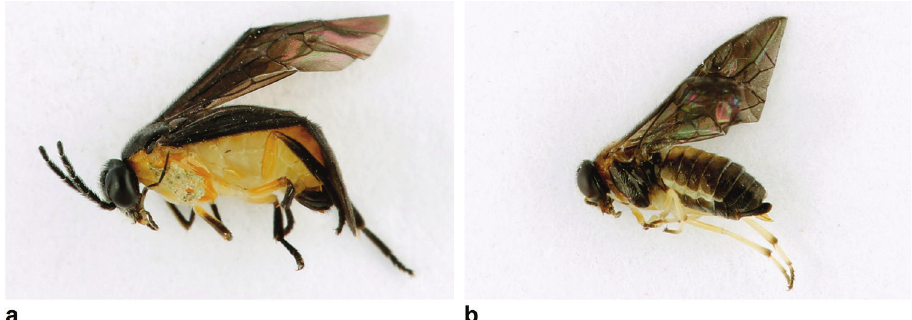
Figure 10. Acordulecera spp. a Female (P4219.A), body length 4.5 mm b female (P4236), body length 3.5 mm. a, b Lateral views.